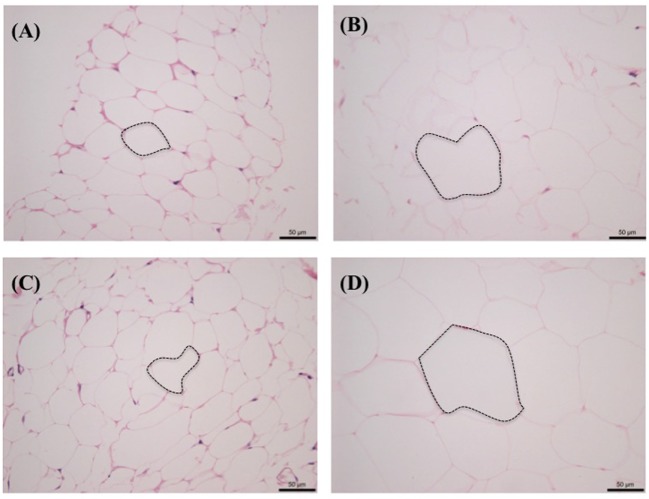
Histological comparison of subcutaneous and omental fat between normal [Body Condition Score (BCS) 3] and obese (BCS 5) cats: (A) omental fat, BCS 3; (B) ometal fat, BCS 5; (C) subcutaneous fat, BCS 3; and (D) subcutaneous fat, BCS 5. Note the increased adipocyte size (emphasized with dotted lines) and decreased number of adipocytes with increased BCS.